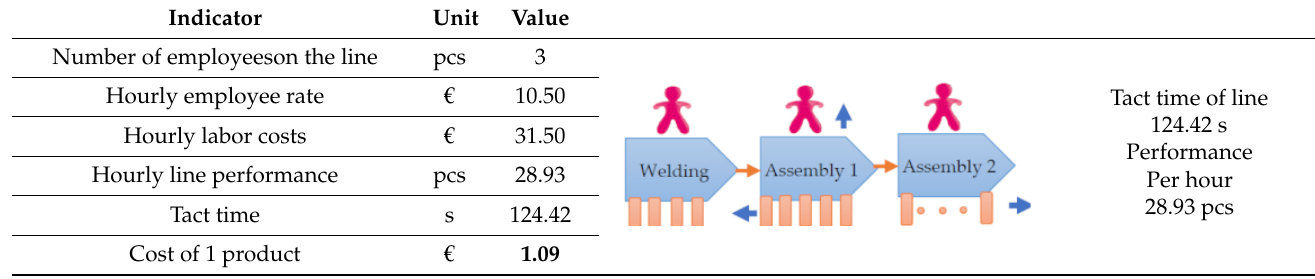
Table 12. Calculation of labor costs for one product when balancing production line